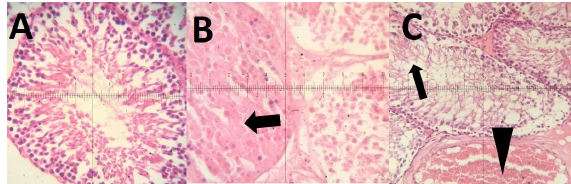
Figure 3. Light Micrographs of Testis Sections; A: control rats. B: lead-treated rat; arrow shows necrosis of seminiferous tubules. C: kidney section of a CeNPs-treated lead-intoxicated rat; arrow shows necrosis (H & E staining. Microscopic magnification ×